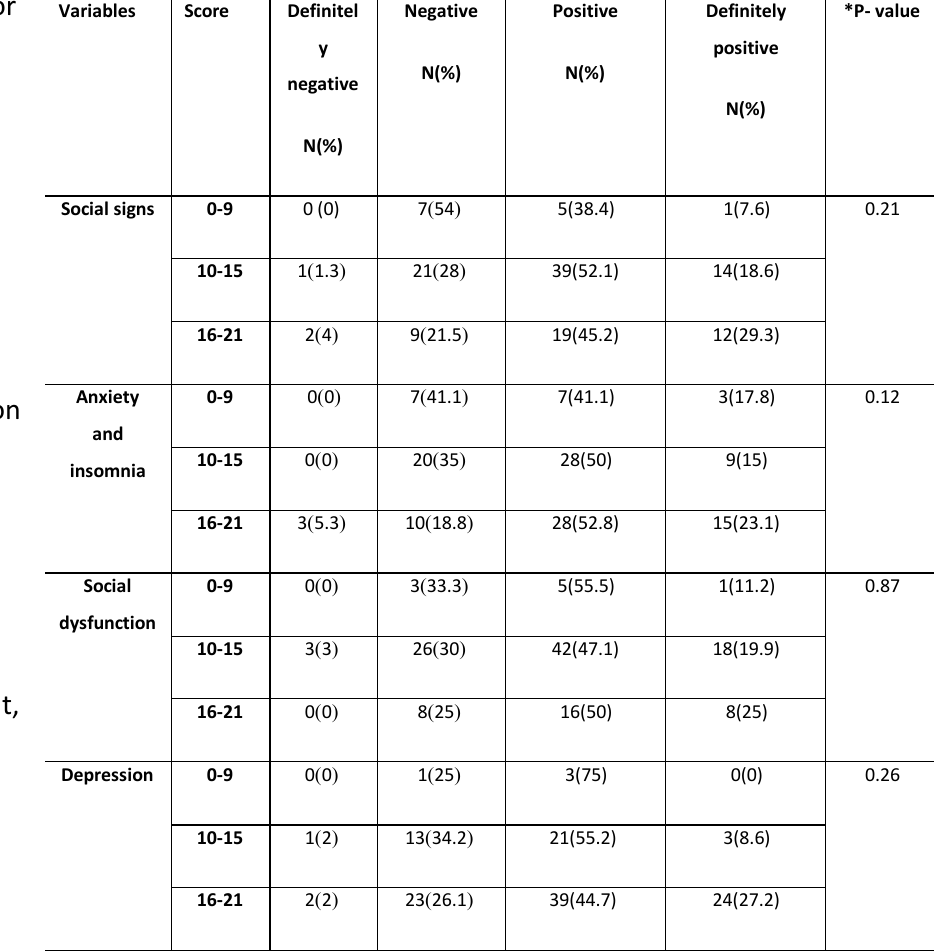
Table 3. Frequency distribution of parental general health by cooperation level of children